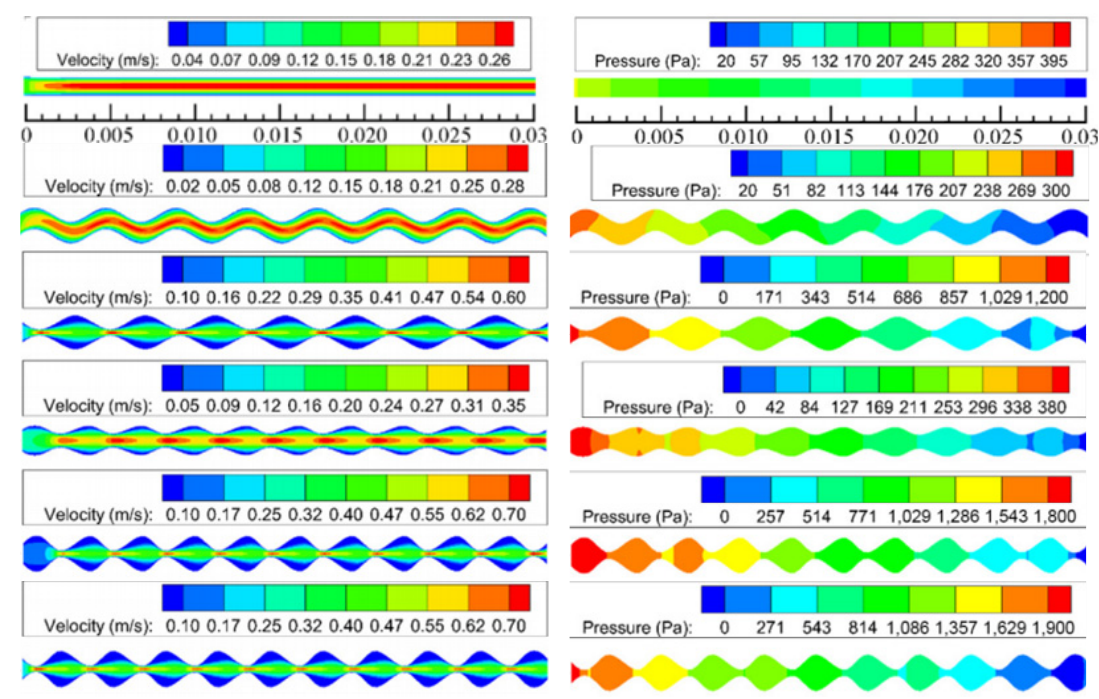
Figure 7. Comparison of velocity and pressure distribution of various geometry on the sidewall of microchannels (adapted from Ref. [86]).